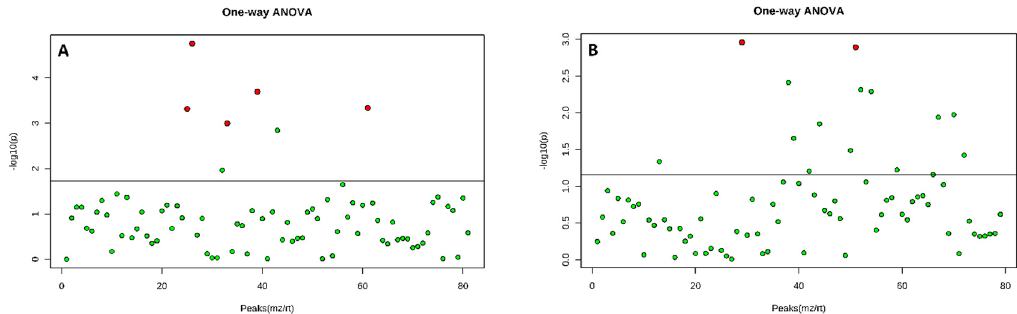
Figure 2. Volatile organic compounds collected from Hybrid Tea flowers after application of benzyladenine BA ( A ) and naphthalene acetic acid NAA ( B ), the red dots represent the volatile compounds which are significantly ( p < 0.05) different to the total collected volatile compounds. Principal component analysis PCA analyses were used with one-way ANOVA.